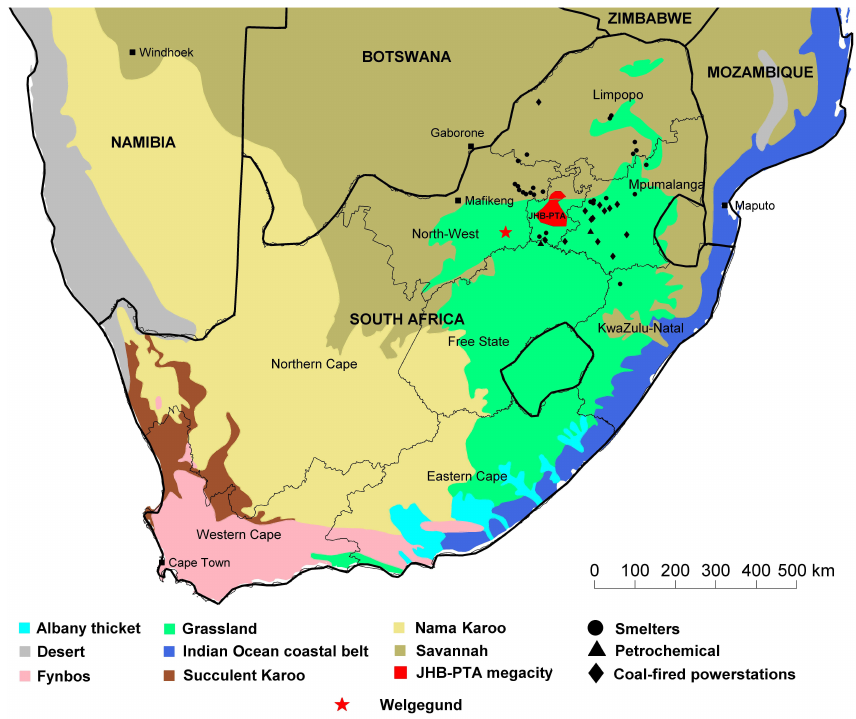
Figure 1. Map of southern Africa indicating the location of the Welgegund measurement station within the context of the bioregion and large point sources in the industrial hub of South Africa (Mucina and Rutherford,